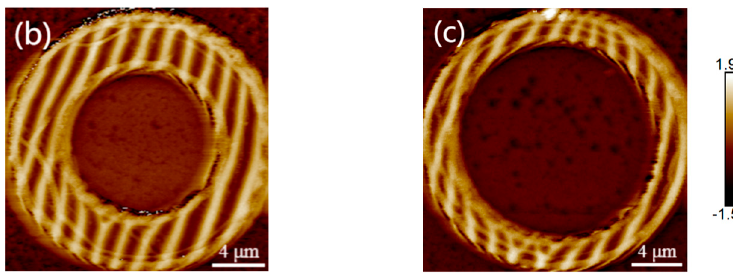
Figure 4. Stripe magnetic domain structure of ring-patterned CoFeB with different line widths: ( a ) 8 µ m, ( b ) 4 µ m, ( c ) 2 µ m.